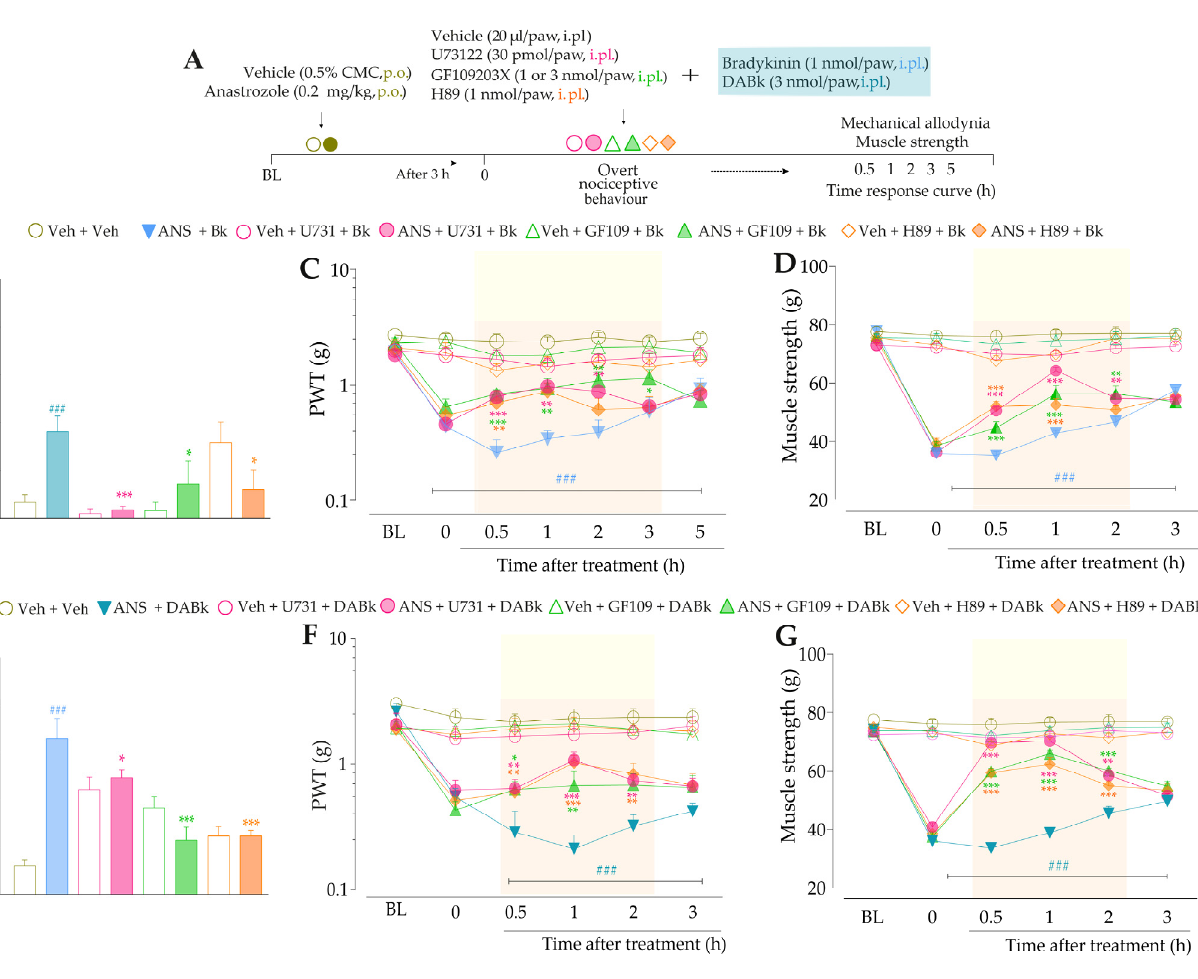
Figure 7. The signaling pathways downstream from the kinin B 2 and B 1 receptors are activated and contribute to the nociceptive behaviors induced by kinin agonists in anastrozole-treated mice. ( A ) Male C57BL/6 mice were treated by the oral route (p.o.) with anastrozole (0.2 mg/kg) or its vehicle (0.5% CMC) to induce painful behaviors. At 3 h after anastrozole administration (Time 0), the animals received the intraplantar (i.pl.) co-injection of U73122 (30 pmol/paw, i.pl., PLC inhibitor), GF109203X (1 or 3 nmol/paw, i.pl., PKC inhibitor), or H89 (1 nmol/paw, i.pl., PKA inhibitor), and a sub-nociceptive dose of Bk (1 nmol/paw, i.pl.) or DABk (3 nmol/paw, i.pl.). The overt nociceptive behavior was immediately evaluated for 10 min ( B , E ); the PWT ( C , F ) and strength muscle ( D , G ) were assessed until treatments with the inhibitors showed an effect. Baseline (BL) values were measured before the anastrozole or vehicle administration. ### p < 0.001 vs. Veh plus Veh group. * p < 0.05, ** p < 0.01, and *** p < 0.001 vs. ANS plus Bk group. Data were expressed as the mean + SEM (n = 6/group) and analyzed by one- or two-way ANOVA followed by the Bonferroni post hoc test, except for the U73122 e ff ect on overt nociceptive behavior induced by ANS plus Bk and the H89 e ff ect on overt nociceptive behavior induced by ANS plus DABk, which were analyzed by Student’s t-test. Veh: intraplantar or oral vehicle injections; ANS: oral administration of anastrozole to induce the pain model; Bk: bradykinin intraplantar treatment; U731: U73122, a PLC inhibitor; GF109: GF109203X, a PKC inhibitor; PWT: paw withdrawal threshold.